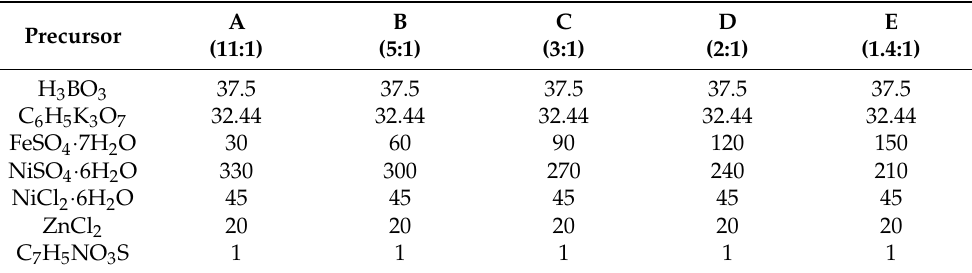
Table 5. Composition of electrodeposition baths